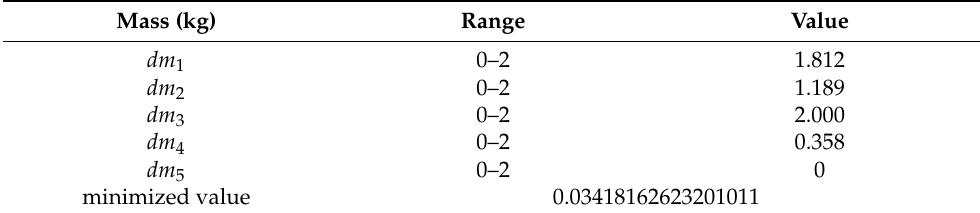
Figure 9. Modified structure after adding masses. Table 5. Parameters of added masses.